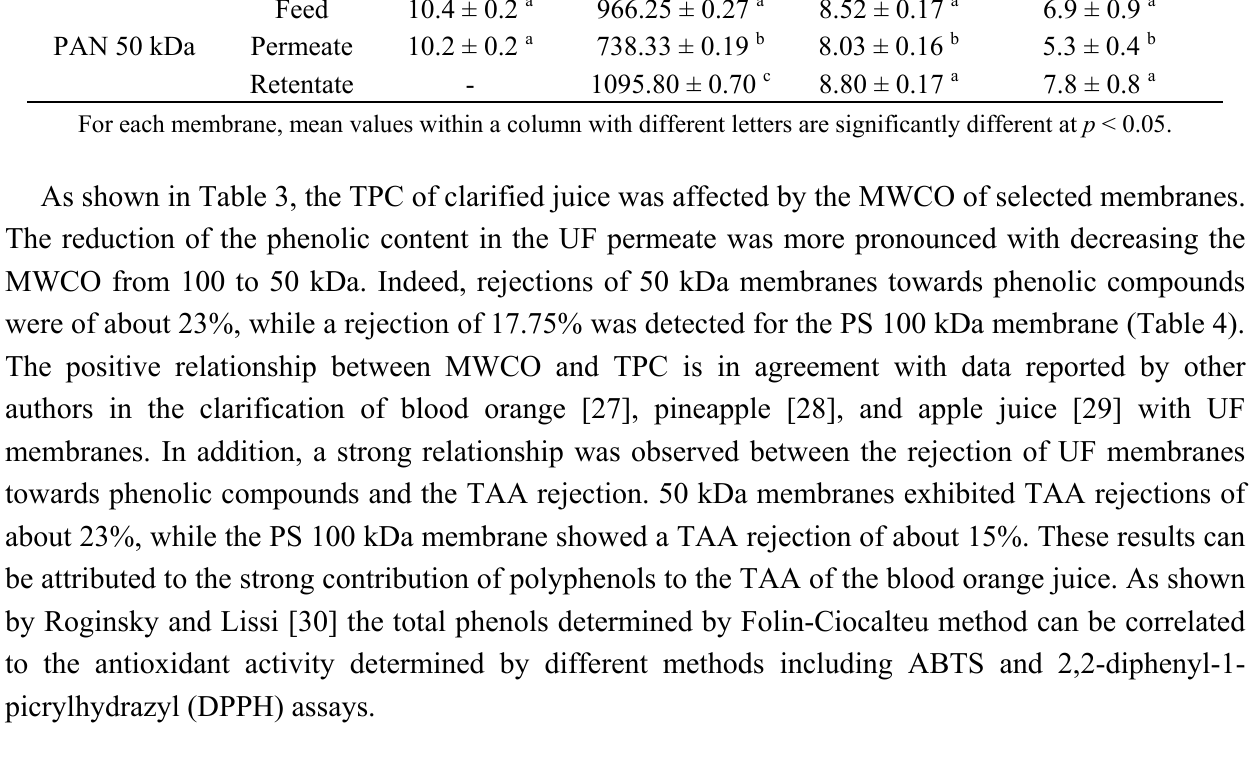
Table 4. Rejection of different UF membranes towards TPC, TAC, TAA, and TSS of blood orange